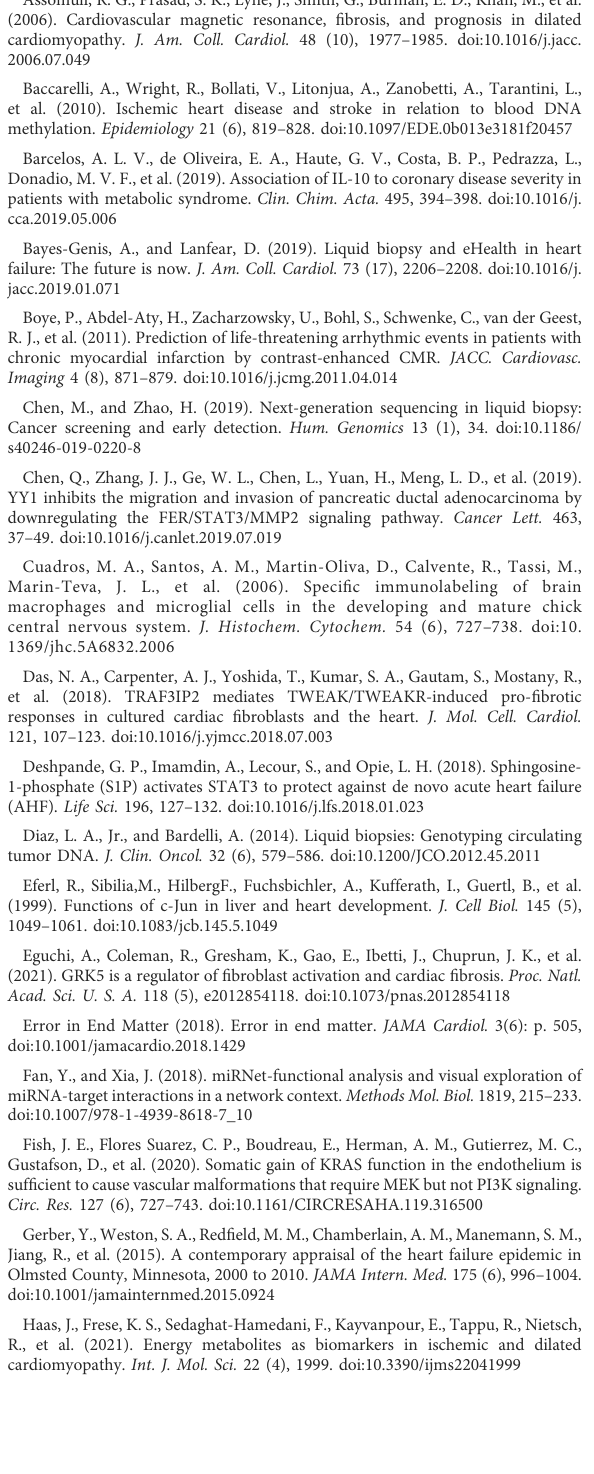
SUPPLEMENTARY TABLE S5 The fi brosis-related DEGs were enriched into 317 KEGGs. SUPPLEMENTARY FIGURE S1 Validation of the expression of 6 hub genes in GSE5406, GSE42955 and